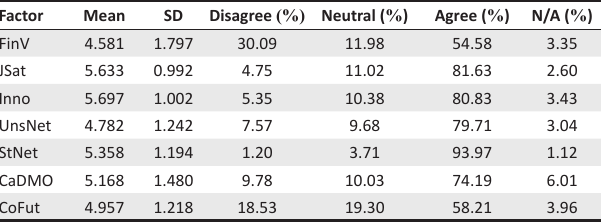
TABLE 3: Descriptive statistics and correlations of the dependent, independent and mediating